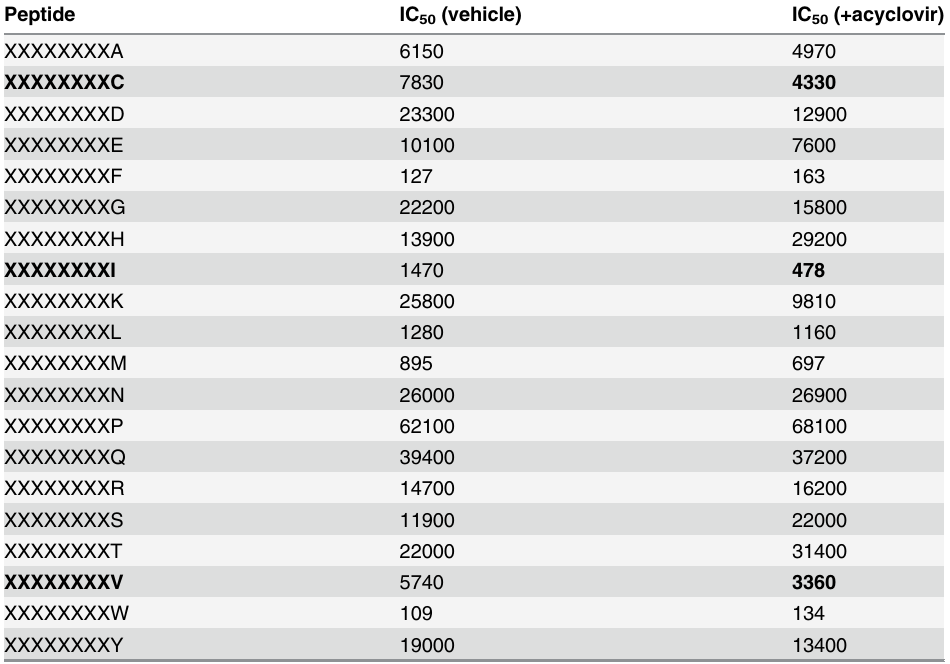
Table 1. Peptide affinity (nM) for HLA-B * 57:01 in the presence of 2 mg/mL acyclovir. Peptide IC 50 (vehicle) IC 50 (+acyclovir) XXXXXXXXA 6150 4970 XXXXXXXXC 7830 4330 XXXXXXXXD 23300 12900 XXXXXXXXE 10100 7600 XXXXXXXXF 127 163 XXXXXXXXG 22200 15800 XXXXXXXXH 13900 29200 XXXXXXXXI 1470 478 XXXXXXXXK 25800 9810 XXXXXXXXL 1280 1160 XXXXXXXXM 895 697 XXXXXXXXN 26000 26900 XXXXXXXXP 62100 68100 XXXXXXXXQ 39400 37200 XXXXXXXXR 14700 16200 XXXXXXXXS 11900 22000 XXXXXXXXT 22000 31400 XXXXXXXXV 5740 3360 XXXXXXXXW 109 134 XXXXXXXXY 19000 13400 Bold indicates peptides that showed a signi fi cant increase in af fi nity for HLA-B * 57:01 in the presence of acyclovir (as shown in Fig 4) and also had an IC 50 (cid:3) 5,000 nM. Values are derived from the medians of six independent measurements run in